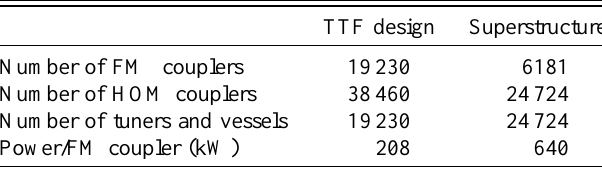
TABLE II. Changes in the rf system.